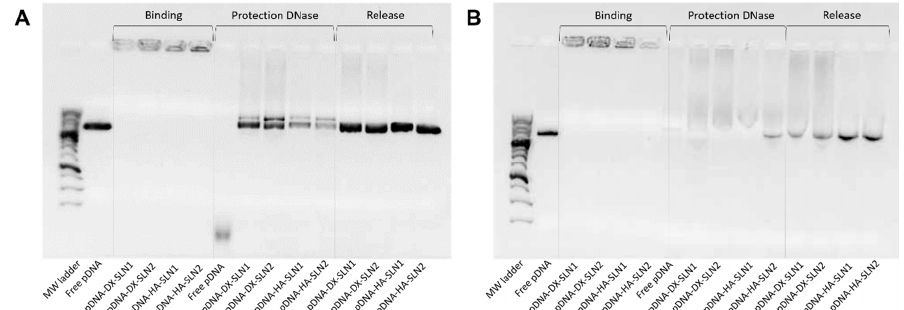
Figure 10. Long-term stability study of the binding, protection and release of pDNA-based vectors formulated with SLN1 and SLN2. ( A ) Binding, protection and release after one month of storage. ( B ) Binding, protection and release after three months of storage.